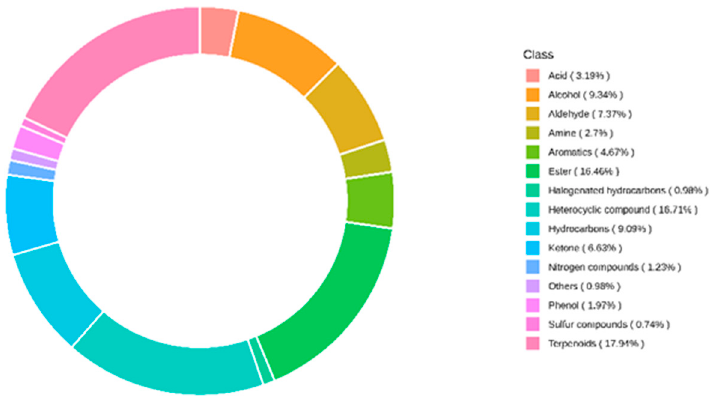
Figure 5. The proportion of the identified flavor metabolites in the composition classification.